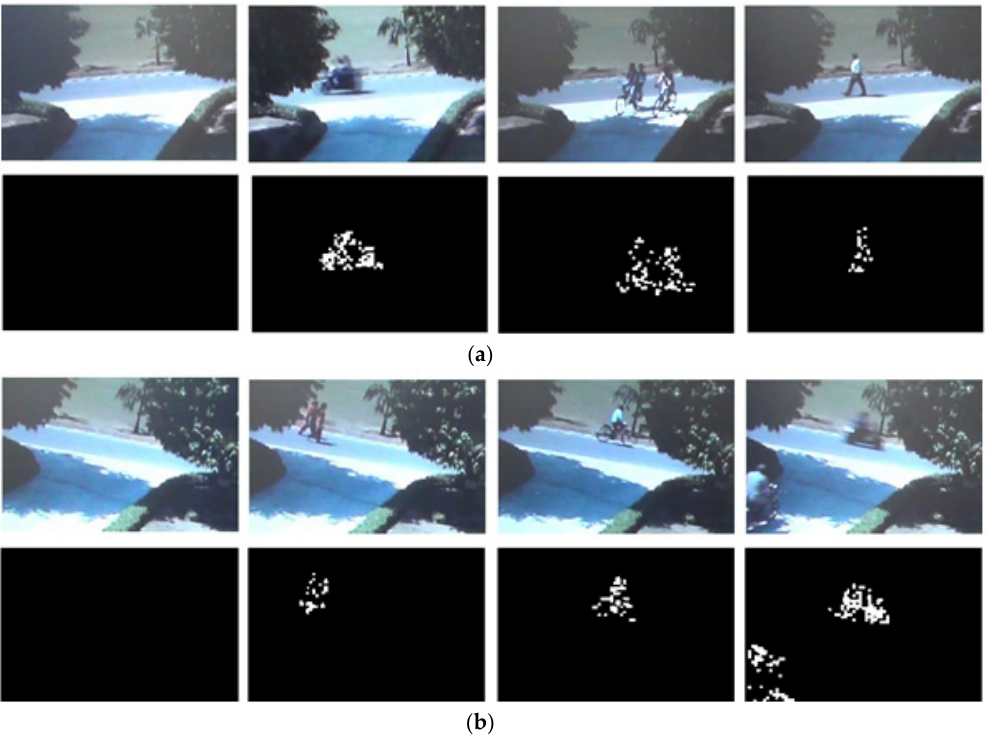
Figure 13. Moving Objects in Video Scene and Corresponding Motion Detected Outputs for Pseudo-stationary Background Scenarios.